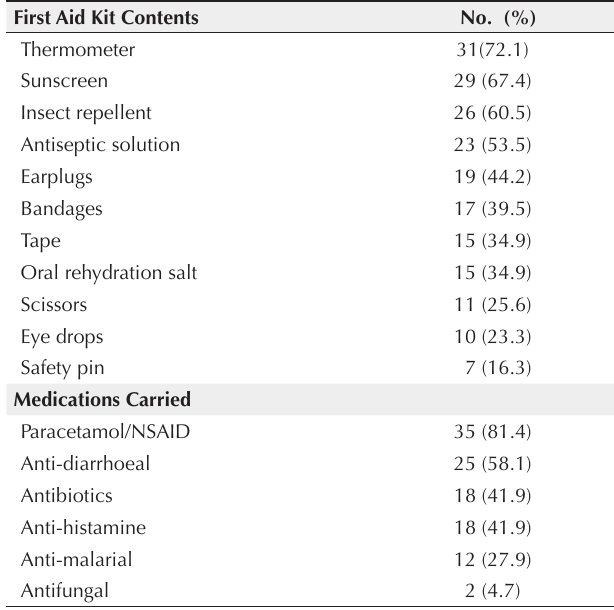
Table 4. First Aid Kit and Medications Carried by Travellers (n =